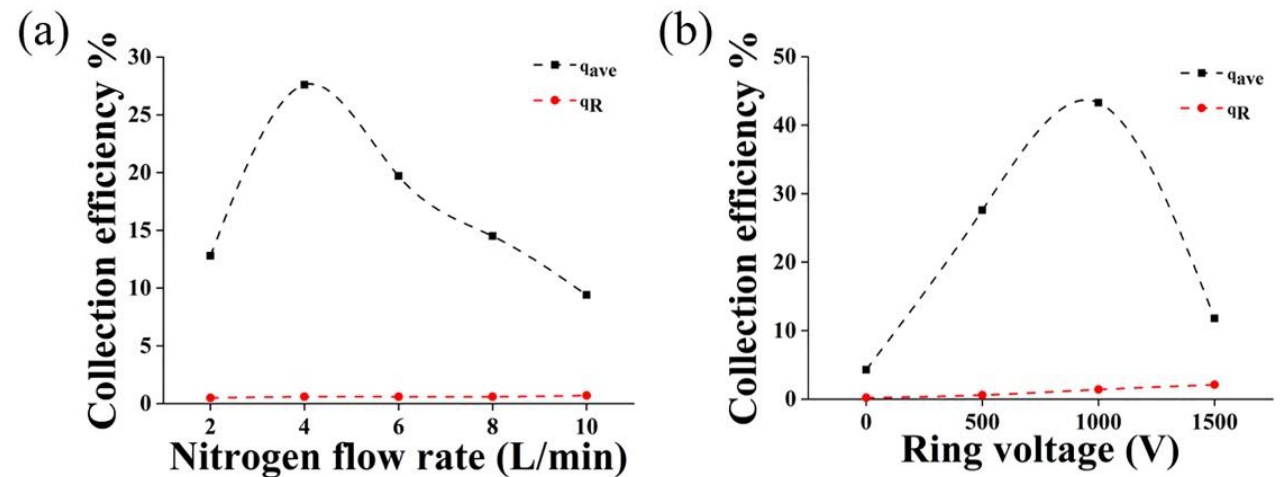
Figure 11. Variations in particle collection efficiency with ( a ) N 2 flow rate (2 – 10 L/min) and ( b ) ring voltage (0 – 1500 V).